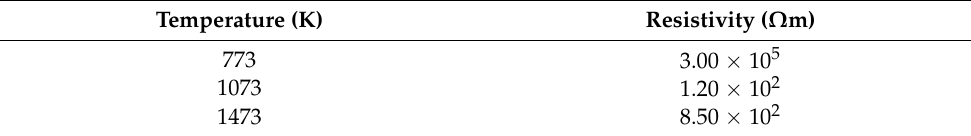
Table 3. Resistivity of rutile TiO 2